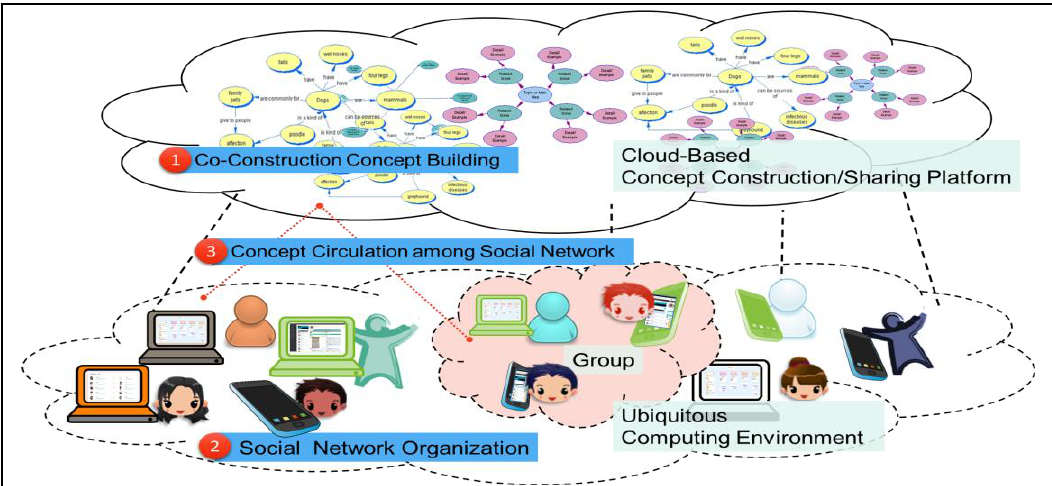
Figure 1. Cloud-based concept construction and sharing platform